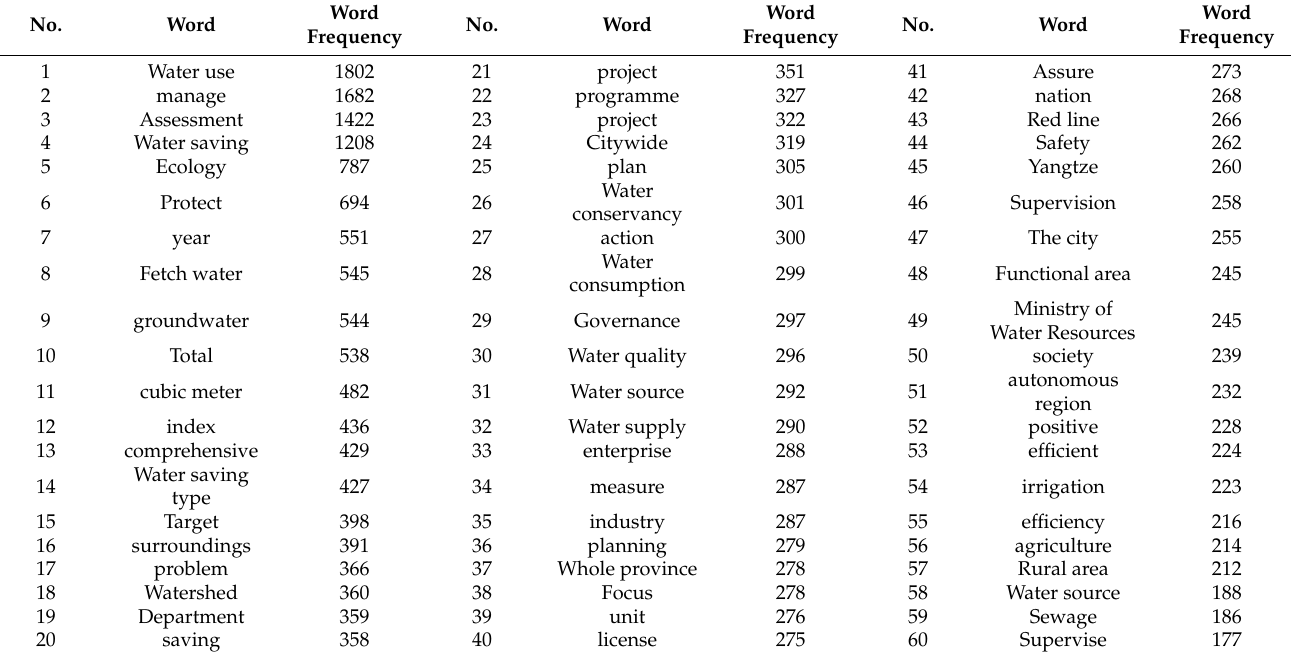
Table 5. Top 60 effective high-frequency words in public